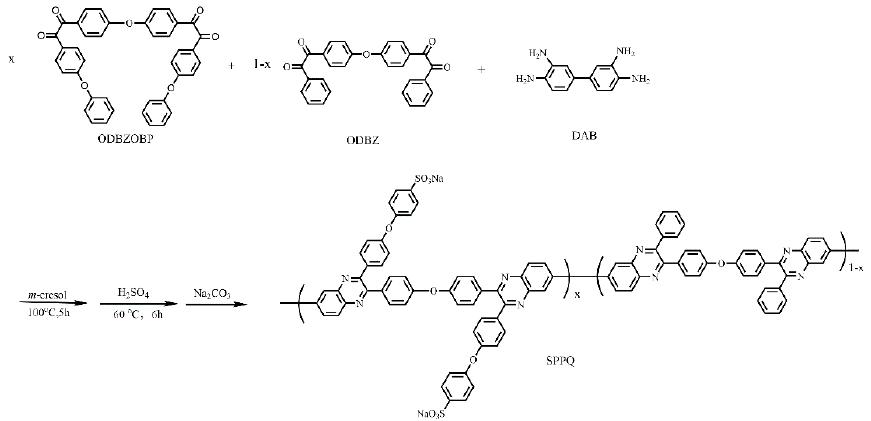
Figure 2. Synthesis of